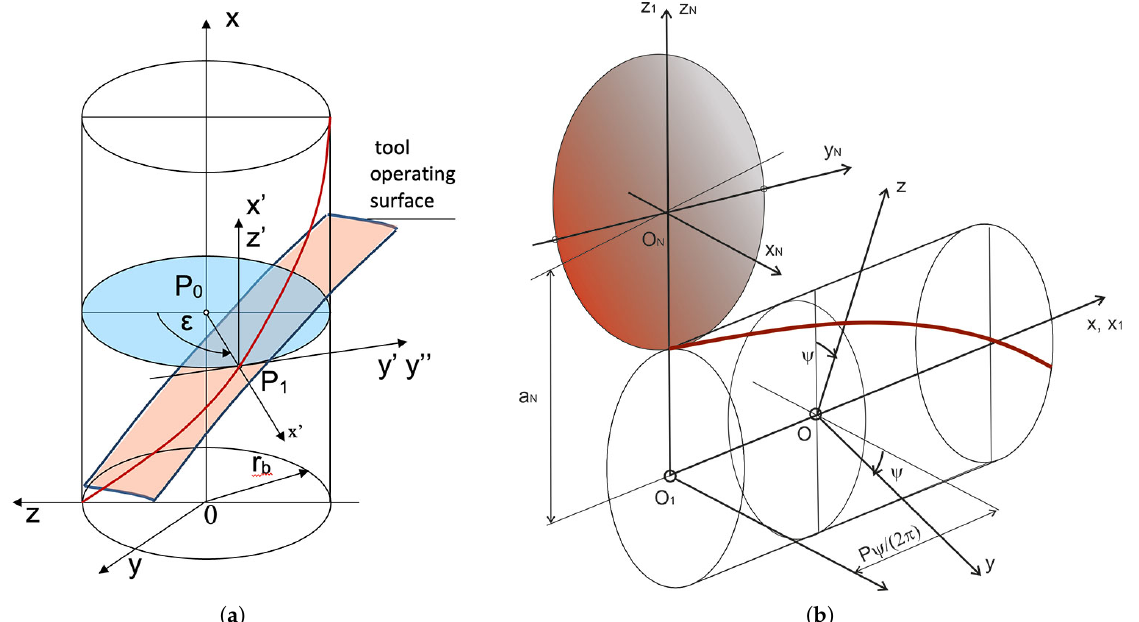
Figure 4. Coordinate system for the analysis of the shaping process of a non-rectilinear helical surface. ( a ) Non-rectilinear helical surface as a general case of enveloping the tool surface in helical motion. ( b ) Helical surface created by shaping with a tool with a defined axial